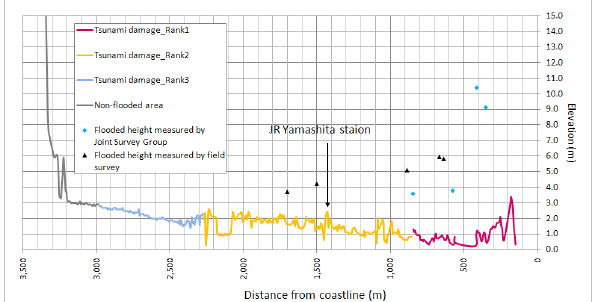
Figure 13. Cross section along EW direction of ground surface and tsunami flood depth on profile D (JR Yamashita Station,